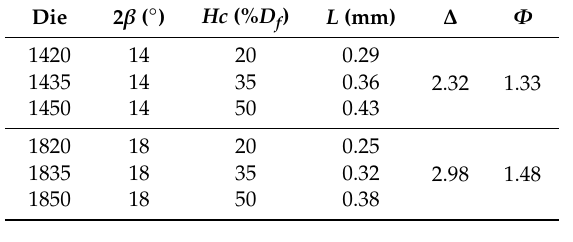
Table 3. Internal geometry parameters of the polycrystal diamond (PCD) dies.